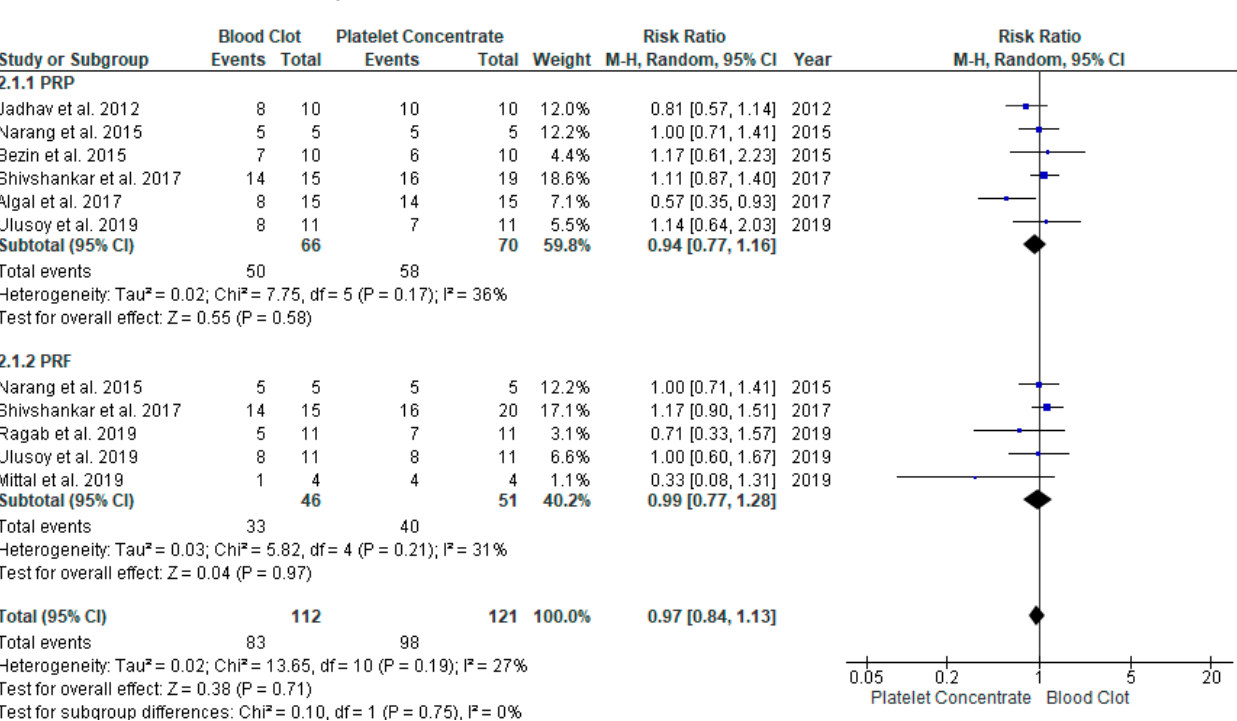
Figure 6. Meta-analysis of apical foramen width (AFW) in regenerative endodontic procedure (REP) using APC or BC.